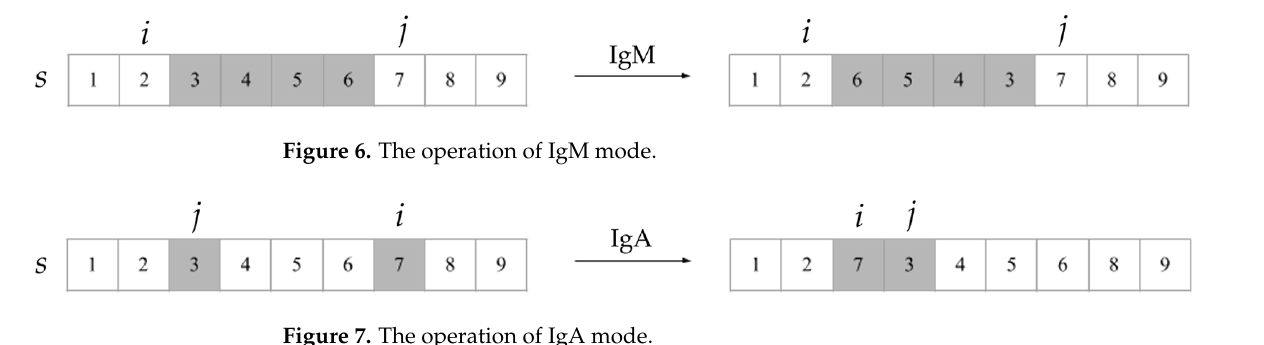
Figure 6. The operation of IgM mode.